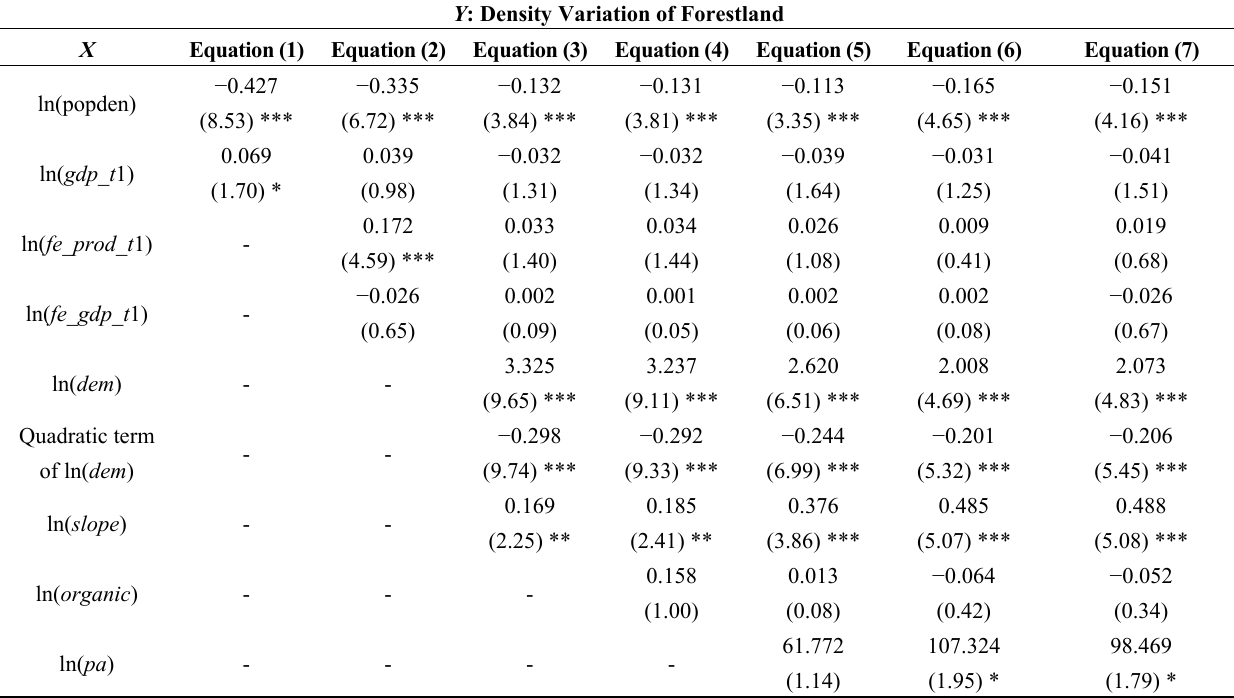
Table 2. Driving mechanism analysis of the density variation of